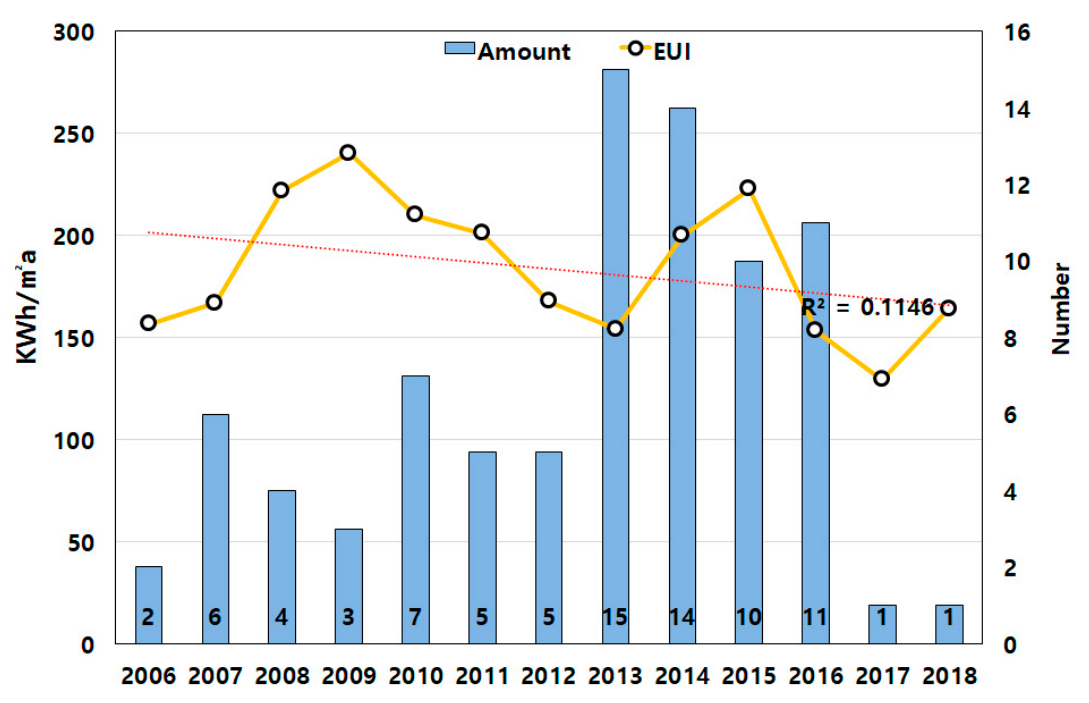
Energies 2020 , 13 , x FOR PEER REVIEW Figure 5. Average EUI of 84 buildings by G-SEED certification year. Figure 5. Average EUI of 84 buildings by G-SEED certification year.